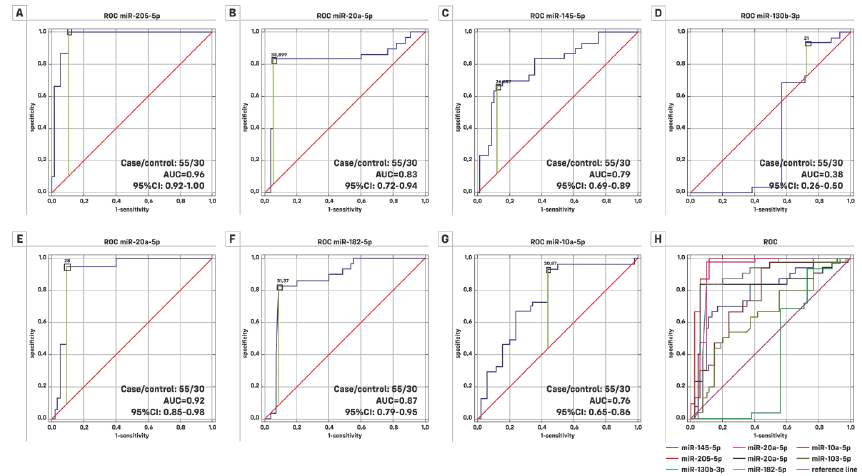
Figure 3. The receiver operating characteristics (ROC) curves for BC prediction using the expression level of ( A ) miR-205-5p, ( B ) miR-20a-5p, ( C ) miR-145-5p, ( D ) miR-130b-3p, ( E ) miR-21-5p, ( F ) miR-182-5p, ( G ) miR-10a-5p and ( H ) summary of curves for all miRNAs. The best classifiers are miR-205-5p, miR-20a-5p and miR-145-5p, as these could significantly discriminate BC patients from the control group by an AUC higher than 0.9; p < 0.05.